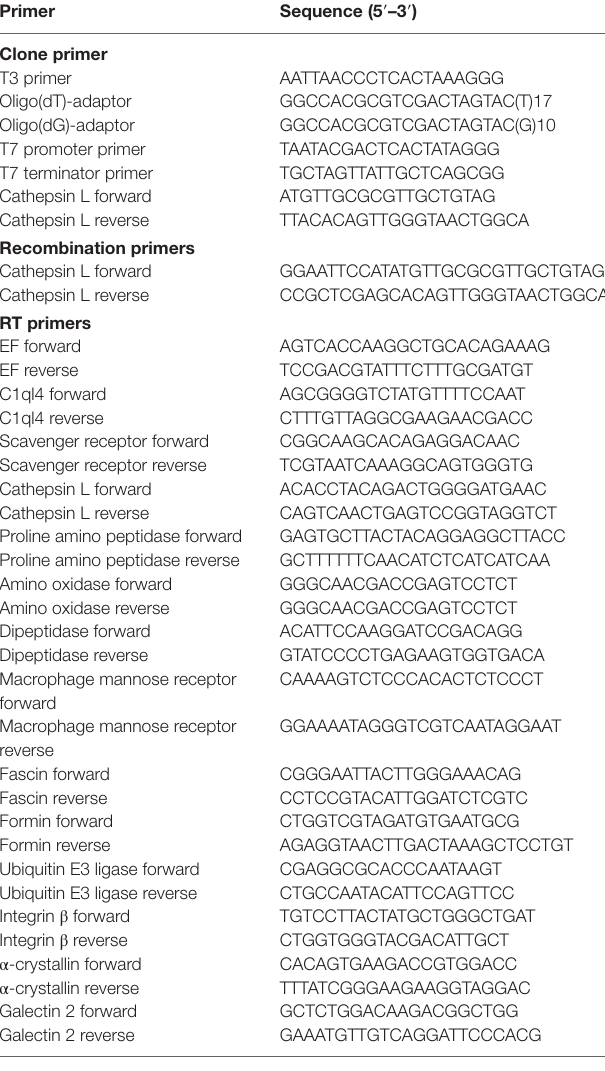
TaBle 1 | Primer nucleotide sequences used in this study. Primer sequence (5 ′ –3 ′